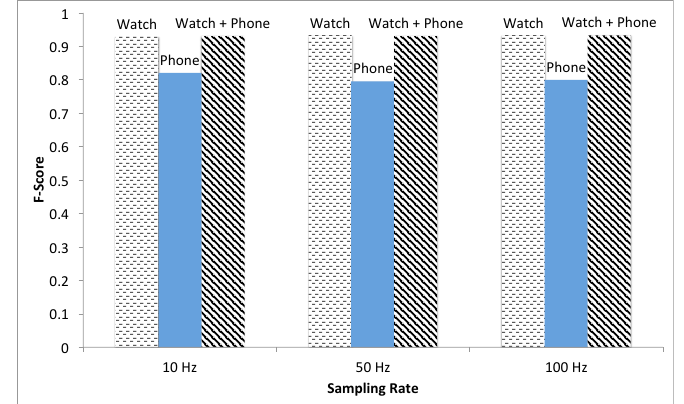
Figure 4. F-scores at three sampling rates for the watch, phone and watch +